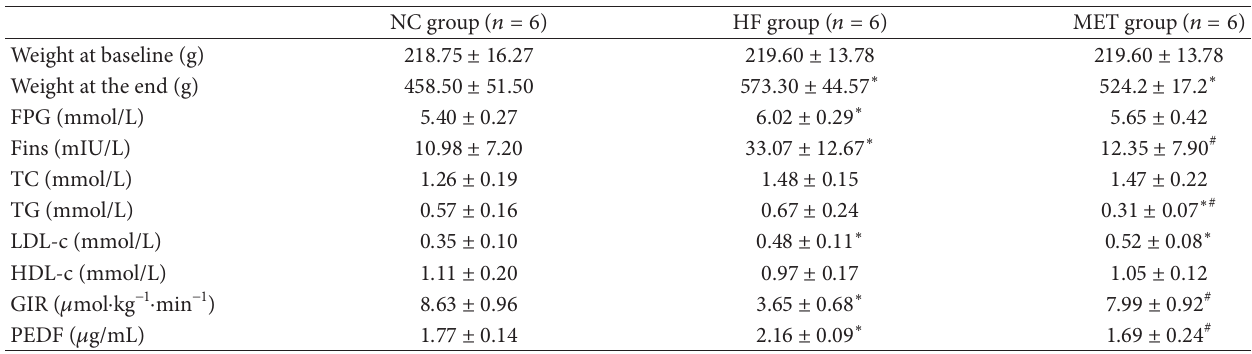
Table 2: Characteristics of the animal models.